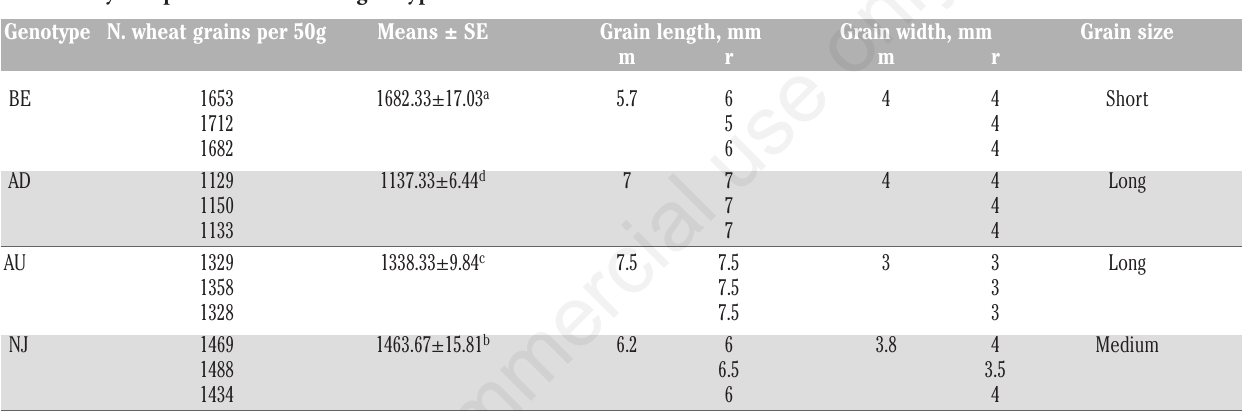
Table 1. Physical parameters of wheat genotypes.